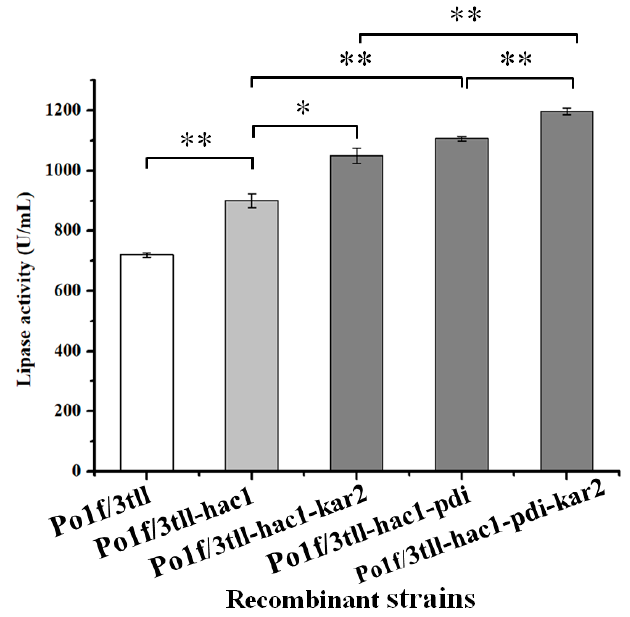
Figure 7. Effect of co-expressing multiple folding-related helper proteins on TLL production in the strain Po1f/3tll. Statistical significance was calculated by unpaired T-test analysis. *: p < 0.05; **: p < 0.01.